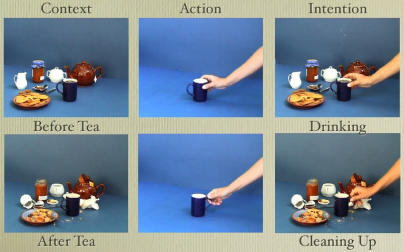
Six Images Taken from the Context, Action, and Intention ClipsThe images are organized in three columns and two rows. Each column corresponds to one of the experimental conditions. From left to right: Context, Action, and Intention. In the Context condition there were two types of clips, a “before tea” context (upper row) and an “after tea” context (lower row). In the Action condition two types of grips were displayed an equal number of times, a whole-hand prehension (upper row) and a precision grip (lower row). In the Intention condition there were two types of contexts surrounding a grasping action. The “before tea” context suggested the intention of drinking (upper row), and the “after tea” context suggested the intention of cleaning (lower row). Whole-hand prehension (displayed in the upper row of the Intention column) and precision grip (displayed in the lower row of the Intention column) were presented an equal number of times in the “drinking” Intention clip and the “cleaning” Intention clip.